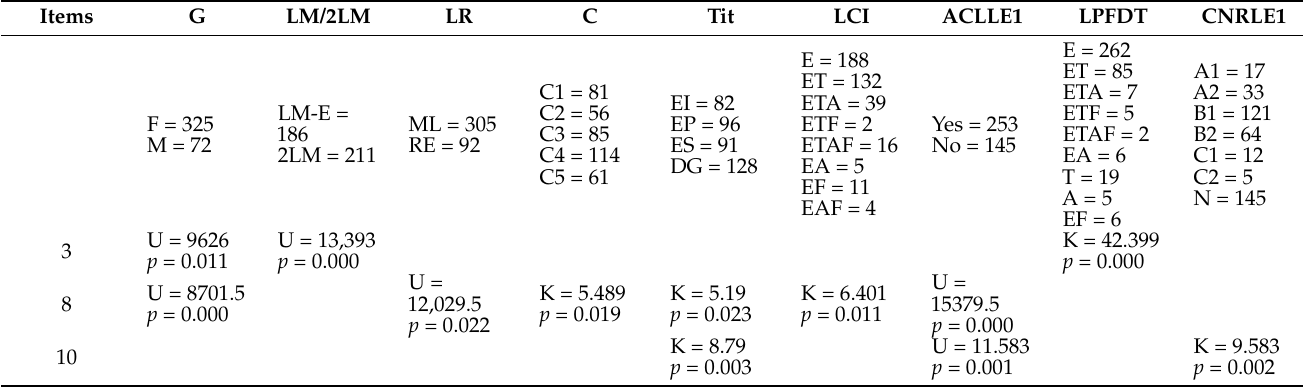
Table 3. Comparative statistics for Dimension 1. Functioning of the